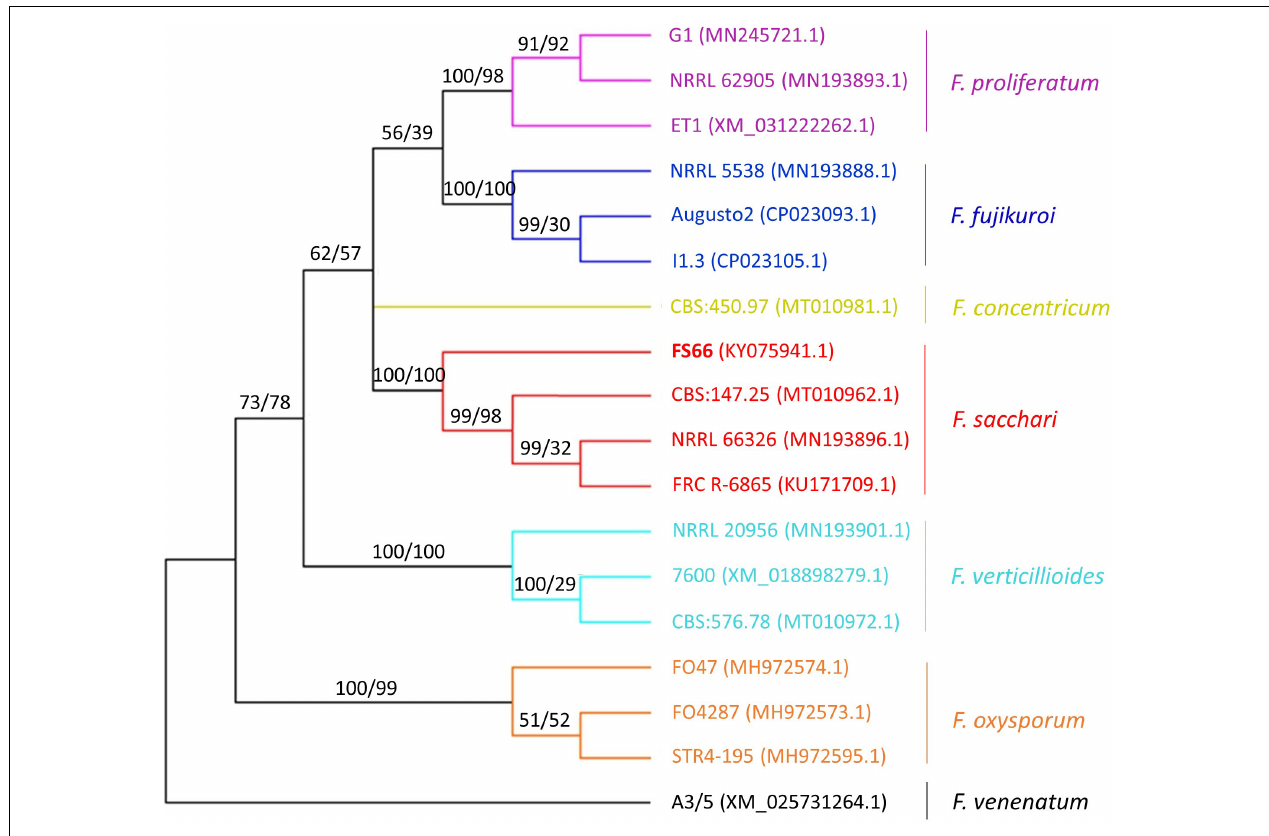
FIGURE 2 | Phylogenetic tree based on the partial coding sequence of RPB2 . The strain names and NCBI accession IDs (in brackets) are shown at the tips. The phylogenetic trees constructed by neighbor-joining (NJ) and maximum likelihood (MX) have the same topology, and the bootstrap support rates (percentage) from NJ and MX are shown before and after the slash next to the bipartition nodes, respectively. Branches corresponding to partitions reproduced in less than 50% bootstrap replicates have been